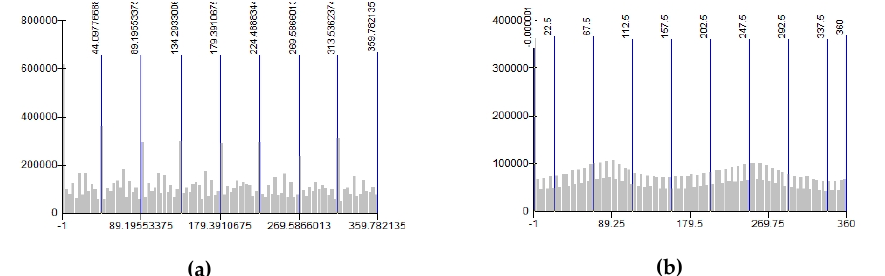
Figure 6. Frequency distribution plots of aspect values for the two studied river basins: ( a ) Pinios and ( b ) Acheloos.